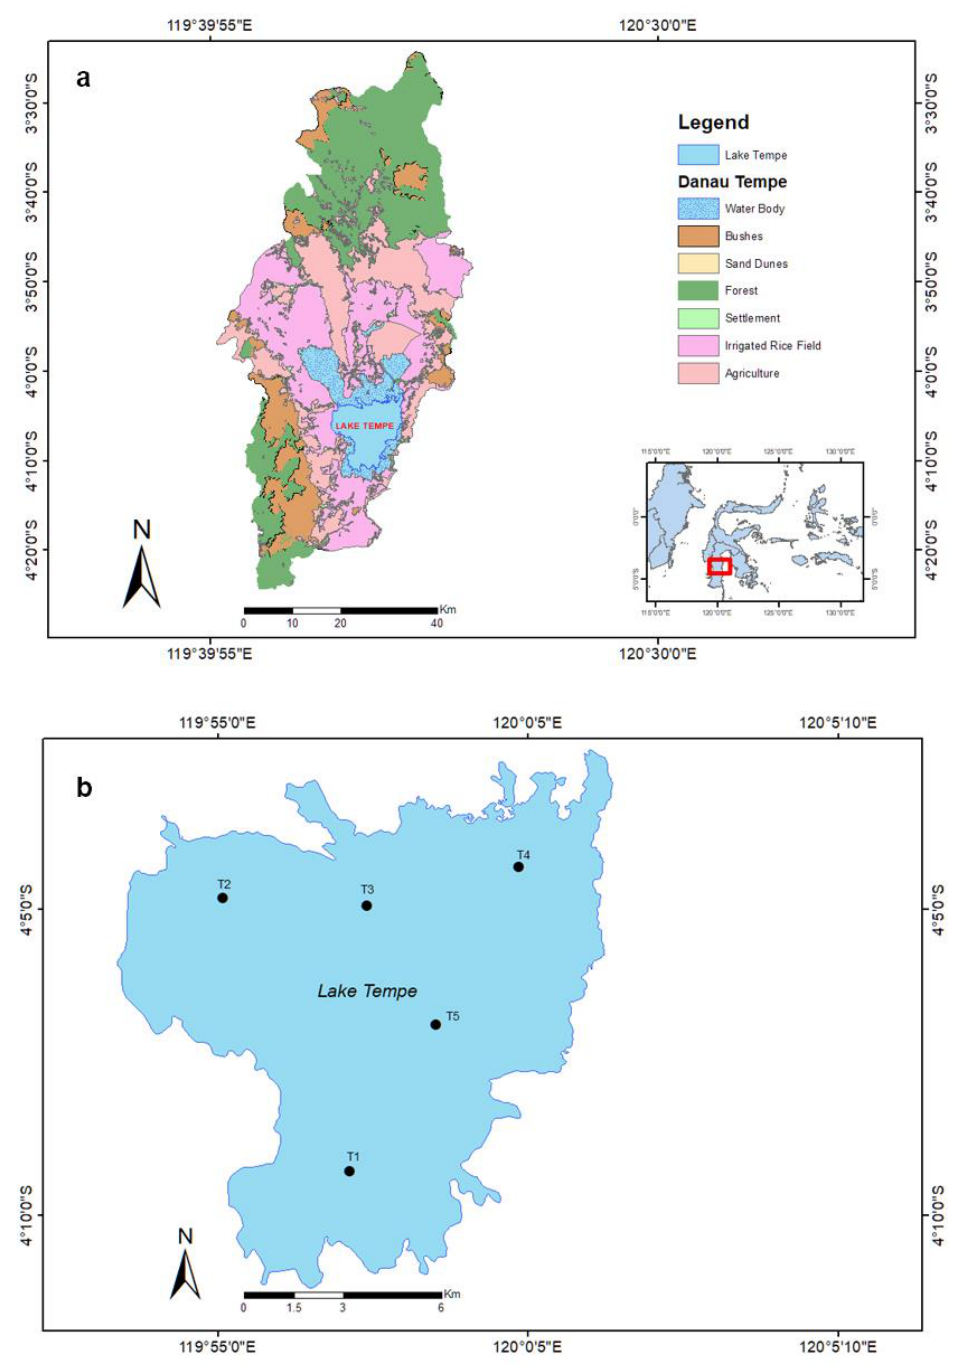
Figure 1. Study area of ( a ) Lake Tempe and ( b ) sampling points in the Tempe floodplain system, where numbers indicate the sampling zones.